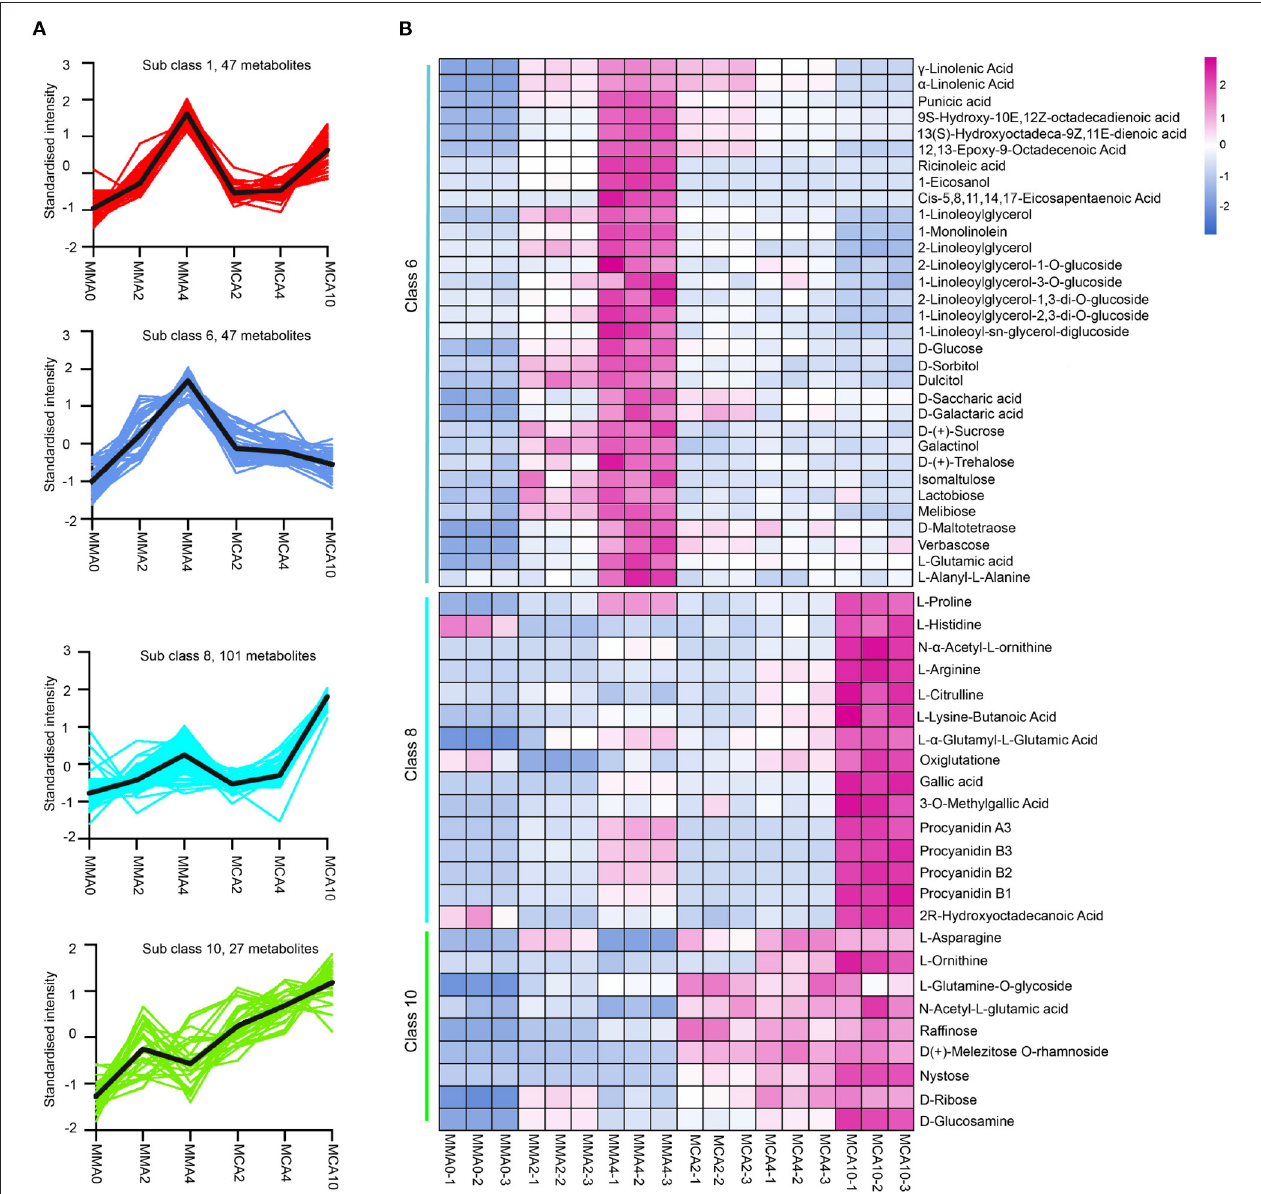
FIGURE 4 | The metabolites up-regulated in MMA4 or MCA10. (A) The four sub classes in which metabolites were up-regulated during maturation at 23 ◦ C or during cold acclimation at 4 ◦ C by K -means analysis. (B) the heatmap of the metabolites (except flavonoids) in K -means sub-class 6, 8, and 10.